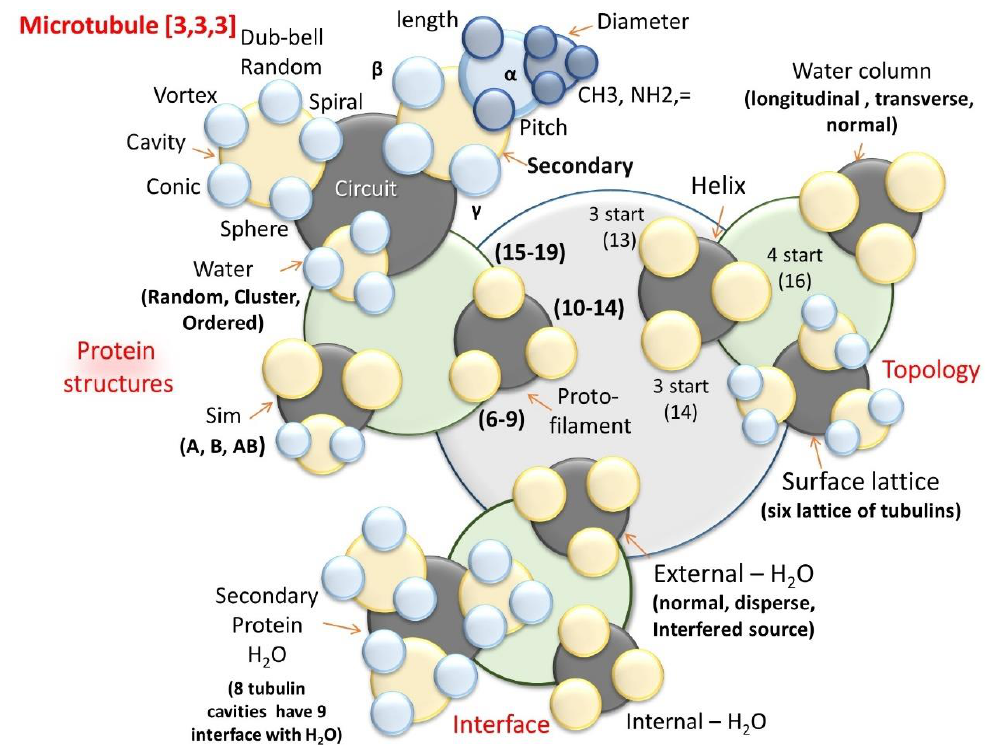
Figure 9. 2D clock architecture or time crystal representation of the neuron of the neural network [41].